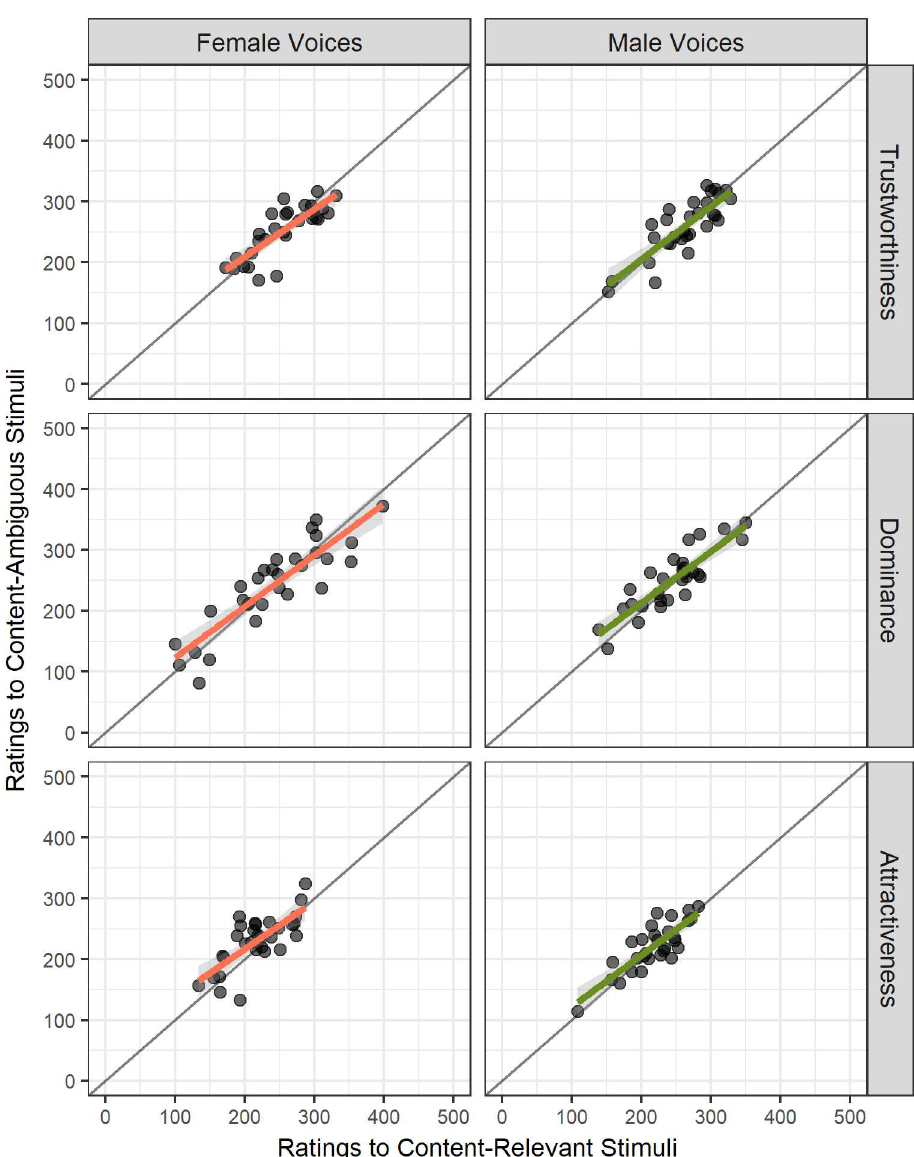
Fig 3. Scatterplot of VAS ratings for content-relevant versus content-ambiguous in female and male voices for trustworthiness (top), dominance (middle) and attractiveness (bottom panel). Female Voices (left) and regression slope (Orange); Male Voices (right) and regression slope (Green); each dot represents a single voice; grey line represents r = 1. p < .05; Males: beta = -80.515, 95CI [-108.182, -53.23], p < .001), and an interaction between content and stimulus type ( Females: beta = .112, 95CI [0.025, 0.2], p < .01; Males: beta = .275, 95CI [0.191, 0.359], p < .001). The interaction was resolved by fitting LMEs for predicting rat- ings to content-ambiguous stimuli from content-relevant stimuli separately for words and then for sentences. Both models fitted random intercept models only for participant and voice and showed a positive effect of content type ( word only — Females: beta = .275, 95CI [0.211, 0.34], p < .001; Males: beta = .123, 95CI [0.063, 0.183], p < .001; sentence only — Females: beta = .400, 95CI [0.34, 0.461], p < .001; Males: beta = .404, 95CI [0.344, 0.466], p < .001). The